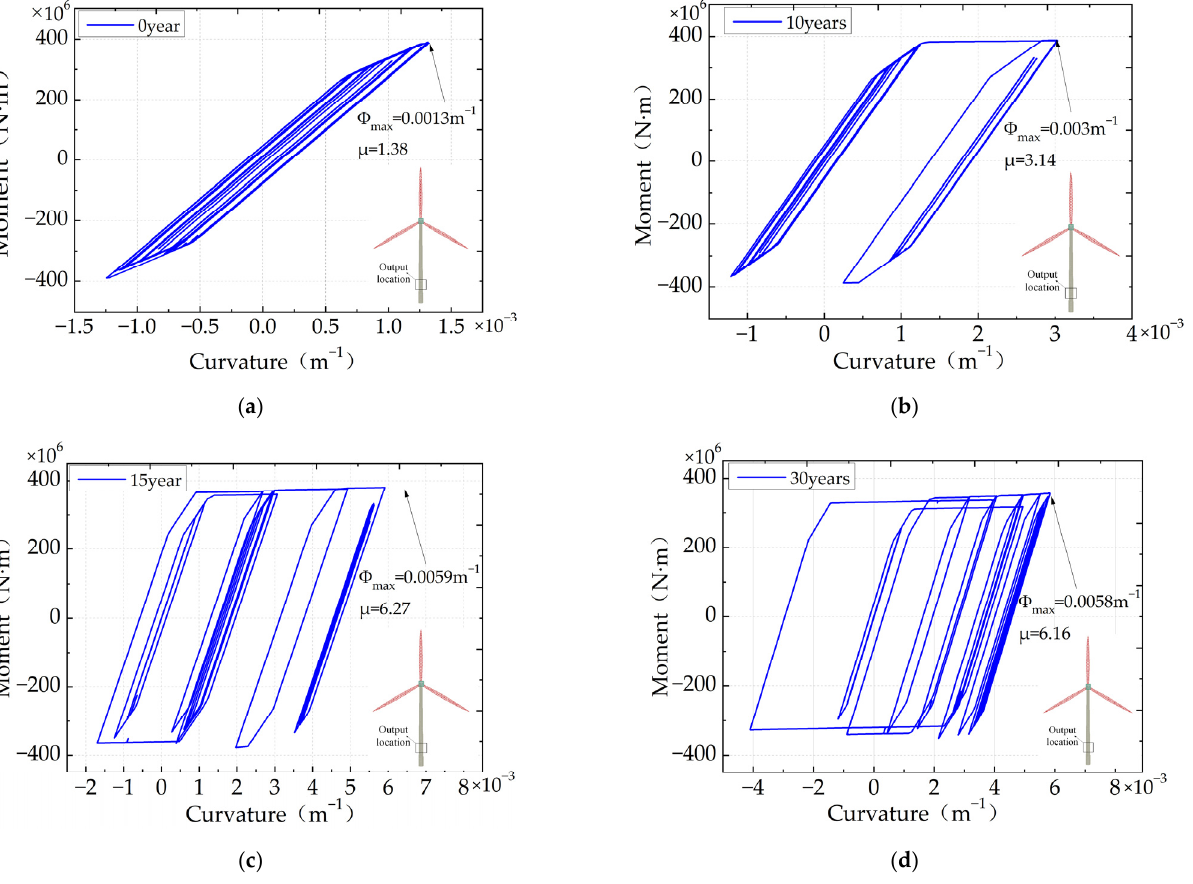
Figure 18. Moment Curvature hysteretic curve of structure under earthquake action: ( a ) Without corrosion; ( b ) 10 years of corrosion; ( c ) 20 years of corrosion; ( d ) 30 years of corrosion.